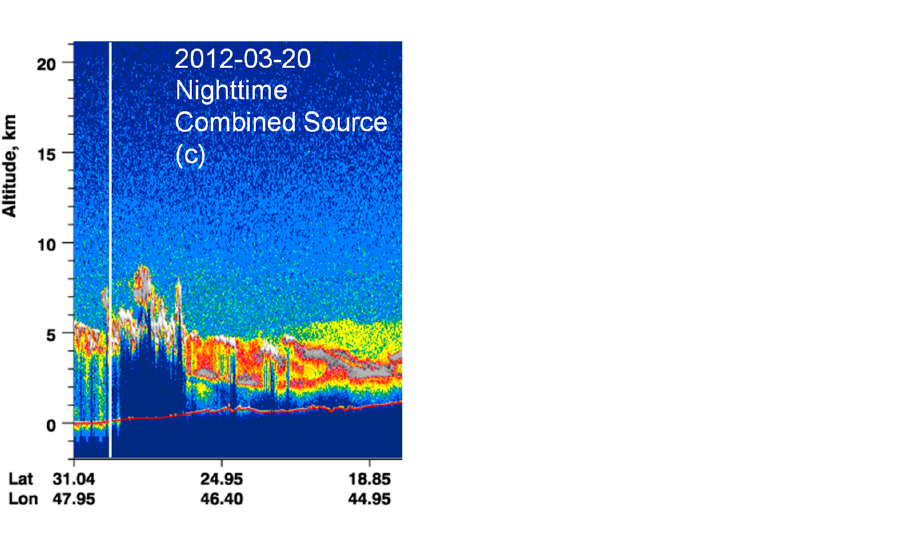
Figure 6. ( a , b ) Dust from combined sources at daytime in clear and cloudy sky conditions. In the image on 6 June 2013, clouds, denoted by the white features are prominent. ( c ) Nighttime image showing significant convective activity near Kuwait City.